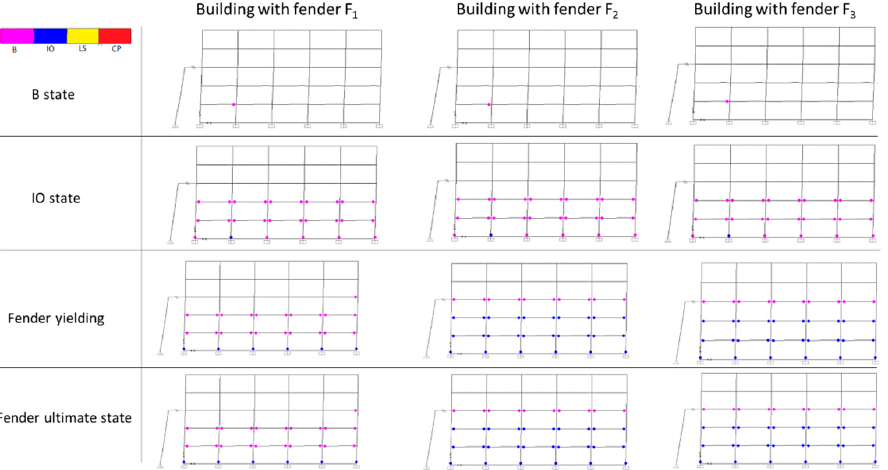
Figure 16. Plastic hinge formation of the building with the fender structure.